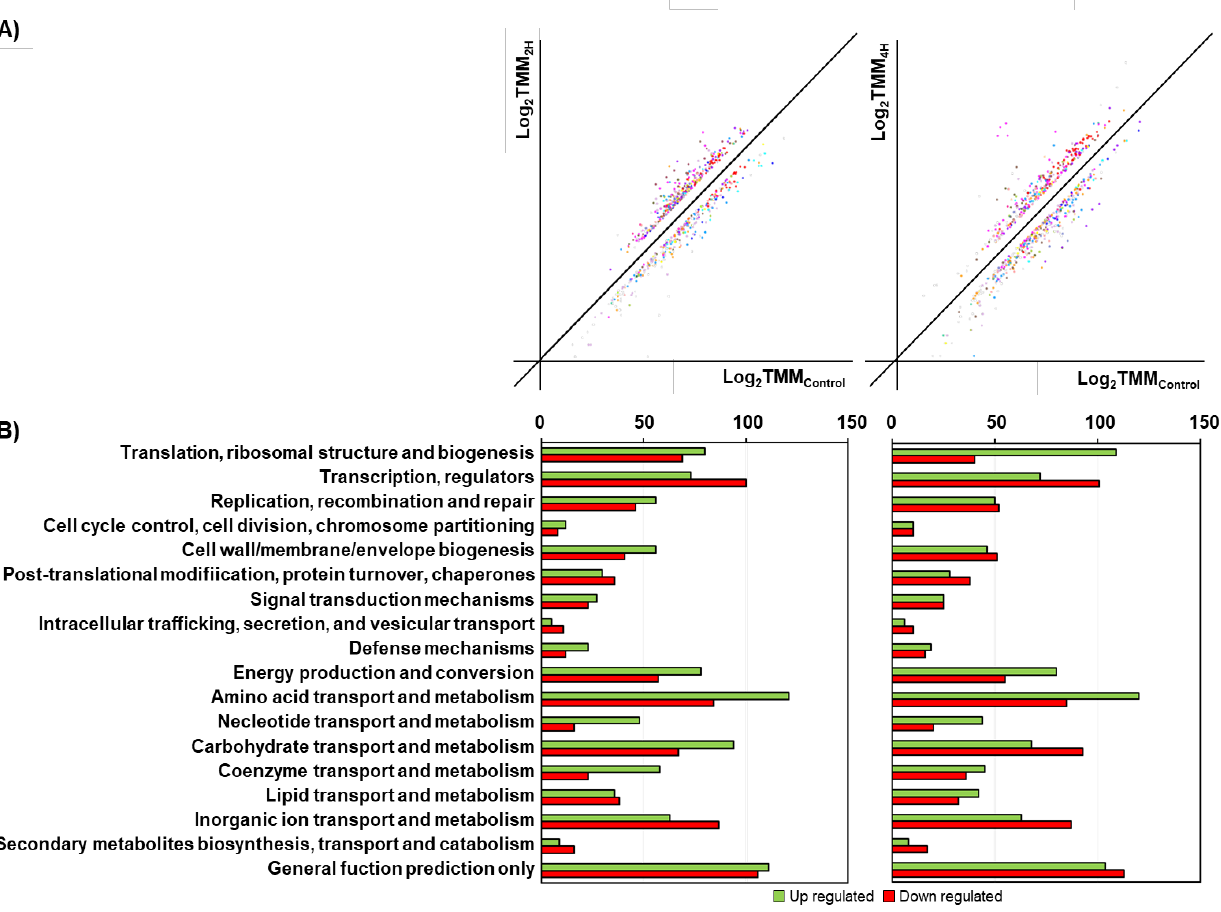
Figure 2. Classification of differentially expressed genes (DEGs) in S. equorum strain KM1031 based on predicted functions. ( A ) DEG analysis from RNA-seq data after salt stress for 2 and 4 h. The x-axis shows log-scaled trimmed mean of M-value (TMM) values for strain KM1031, and the y-axis shows log-scaled TMM values on treatment with 7% NaCl for 2 h (2H) or 4 h (4H). Total gene expressions were filtered to sort significantly down- or upregulated genes with criteria p -value ≤ 0.05 and fold-change ≥ 2. ( B ) Genes up or downregulated by ≥ 2-fold in the presence of salt grouped into functional categories; genes are annotated based on the Clusters of Orthologous Groups database.